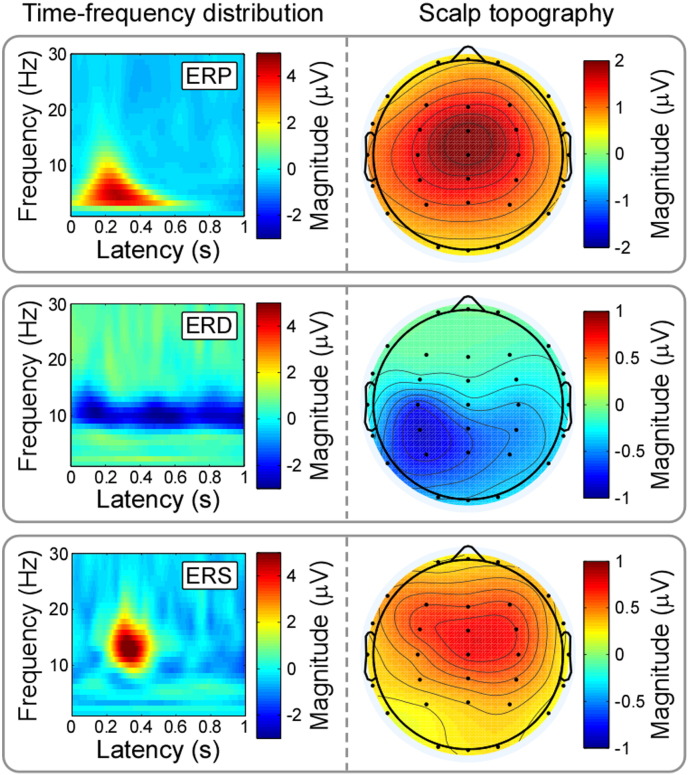
Time-frequency distributions of ERP/ERD/ERS and their scalp topographies.Group-level TFDs and scalp topographies of ERP, ERD, and ERS responses elicited by laser stimulation of the right hand dorsum. The scalp topography of the ERP response is centrally distributed and maximal at the vertex, similarly to that of the N2–P2 complex in the time domain (top panel). The scalp topography of the ERD response has a maximum contralateral to the stimulated side (middle panel). The scalp topography of the ERS response is symmetrically distributed, with a maximum on the frontal electrodes (bottom panel). These different topographies suggest that the three TFD responses have different underlying neural sources.